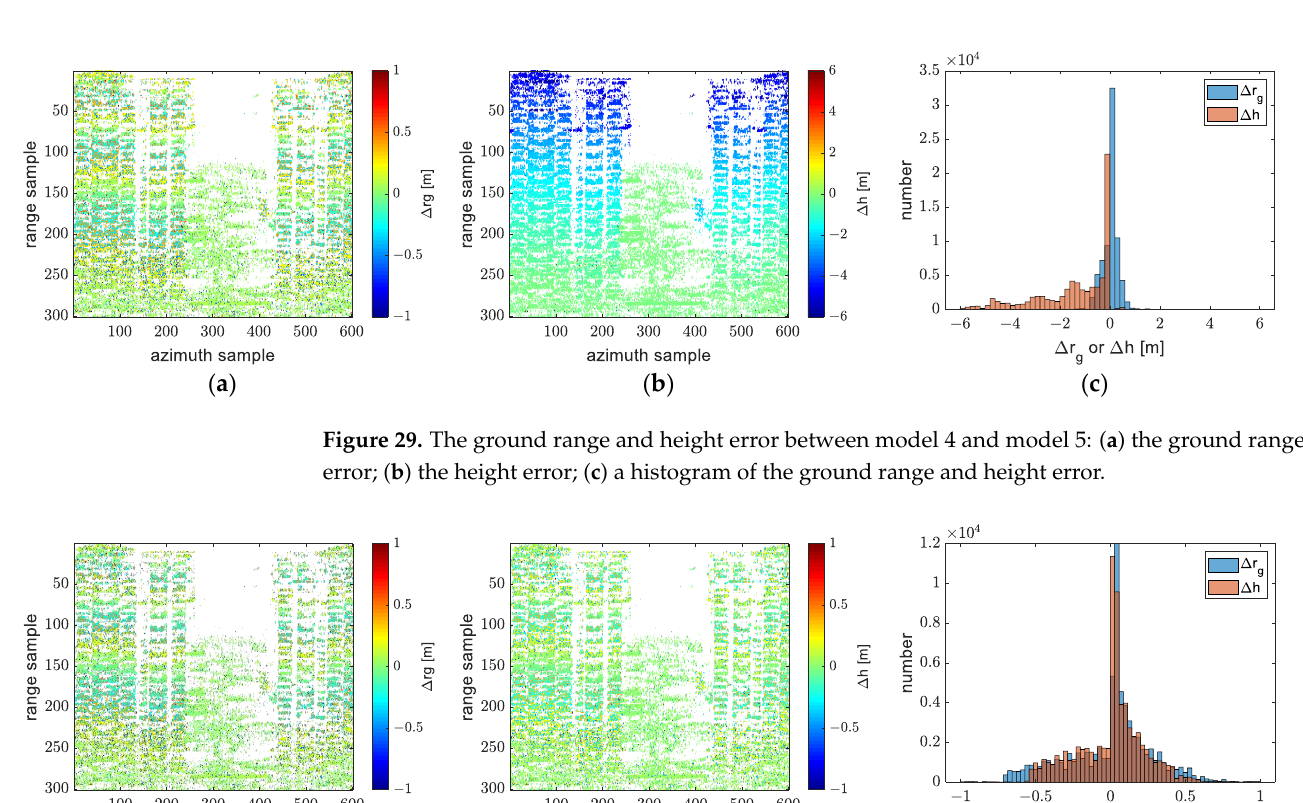
29 of 31 Figure 28. The ground range and height error between model 6 and model 5: ( a ) the ground range error; ( b ) the height error; ( c ) a histogram of the ground range and height error. If we use the experience obtained from the experiments on simulated data, the ground range error between model 4 and model 5 will be about 0 m. But in this experi- ment, the error is approximately in the range of (−1 m, 1 m) , as shown in Figure 29c. The reason is that the baseline incline angles are not all 0 ∘ and are even not equal, as shown in Table 5. For the transformation between model 4 and model 6, the assumption of collinear